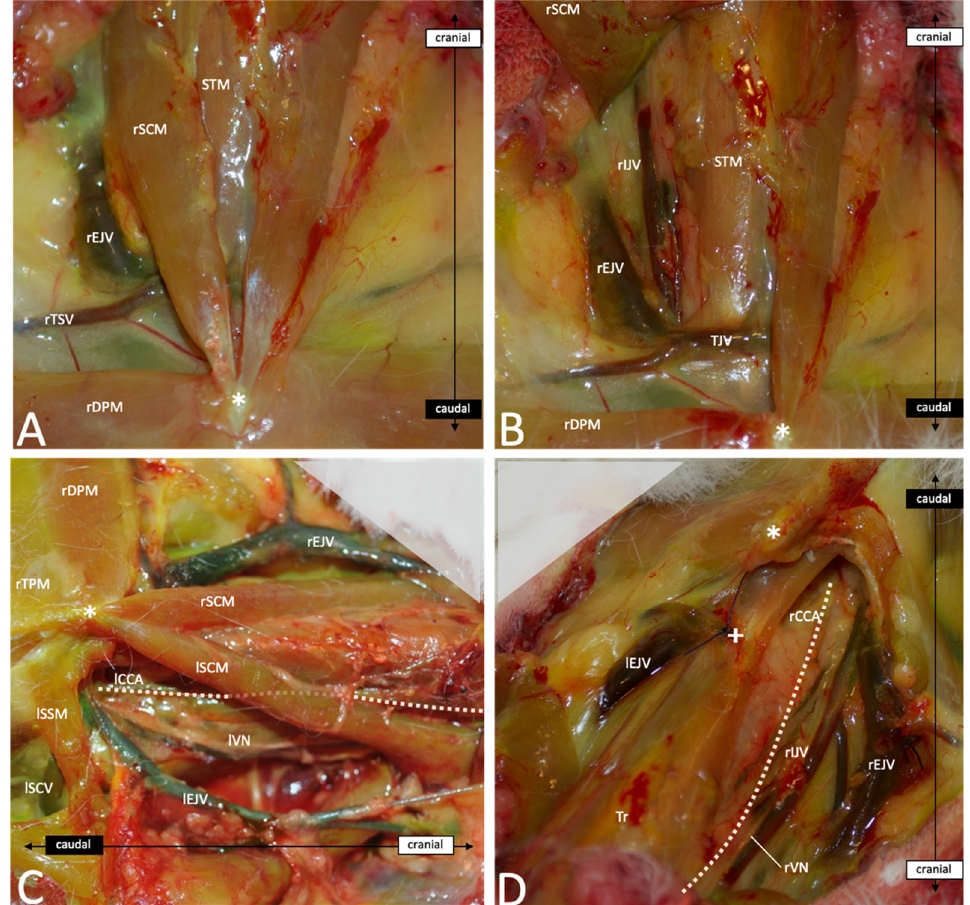
Figure 4. ( A ) Frontal view of the first superficial layer after skin incision and subcutaneous fat tissue dissection. ( B ) Frontal view after proximal section and reclination of the rSCM on the right side. ( C ) Left lateral view (surgical view for the approach on the left side of the neck) after resection of the lDMP and lTPM and dissection of the connective and fat tissue to free the neurovascular structures. The dotted line highlights the course of lCCA. ( D ) Cranial oblique overview on the right side (surgical view for the approach on the rCCA) after resection of the SCMs, the rDPM and rTPM and section of the TJV. The dotted line highlights the course of the rCCA. Abbreviations: *—tip of the manubrium sterni; +—section point of the transversal jugular vein; Tr—trachea; rSCM—right sternocephalicus muscle; lSCM—left sternocephalicus muscle; STM—sternothyroid muscle; rDPM—right descending pectoral muscle; rTPM—right transverse pectoral muscle; lSSM—left sternoscapular muscle; rEJV—right external jugular vein; lEJV—left external jugular vein; rIJV—right internal jugular vein; lIJV—left internal jugular vein; rTSV—right transverse scapular vein; TJV—transversal jugular vein; lSCV—left subclavian vein; lCCA—left common carotid artery; rCCA—right common carotid artery; lVN—left vagal nerve; rVN—right vagal